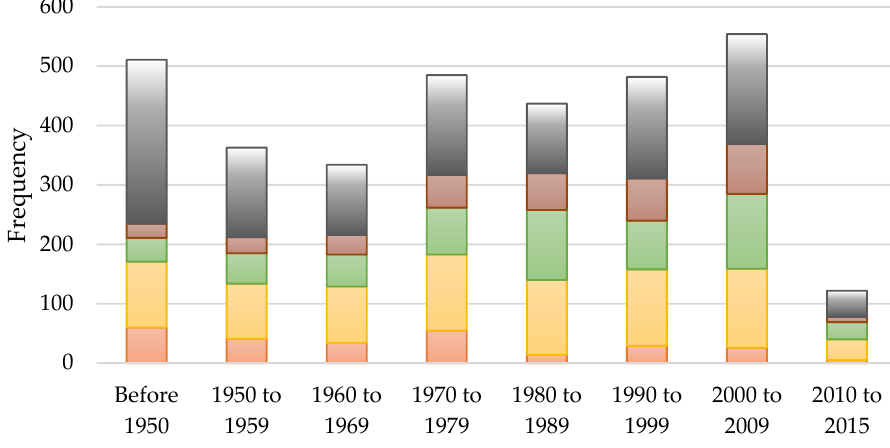
Figure 3. Box plot for the total square footage of homes per climate region. The distribution of building age was fairly stable, with more homes being built be- tween 2000 and 2009 (n = 16.8%) and before 1950 (n = 15.5%). The decades in between these two categories comprise between 10.2% (from 1960 to 1969) and 14.8% (between 1970 and 1979); homes built between 2010 and 2015 comprised the smallest percentage (n = 3.7%). Specific information for building age per climate region can be seen in Figure 4.